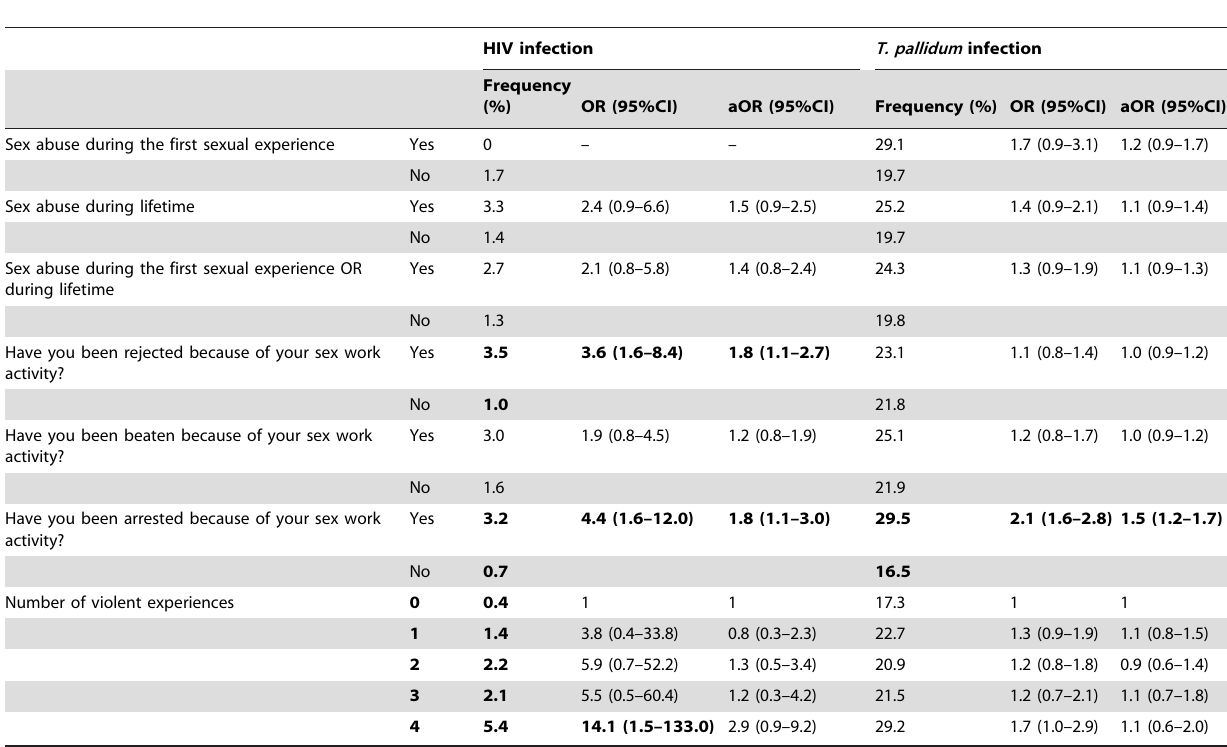
Table 4. Bivariate and multivariate analysis of violent experiences and HIV/ T. pallidum infection in FSWs recruited in nine cities of Argentina between 2006 and